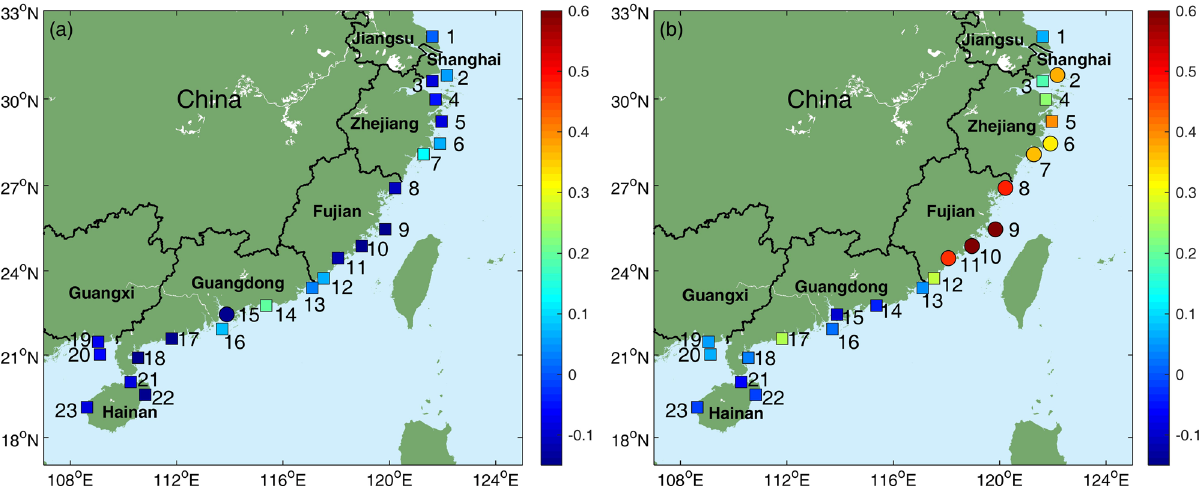
Figure 7. Correlation coefficients between the Niño-3.4 index and annual number of ( a ) Minor-surge events and ( b ) Major-surge events. Figures were plotted using MATLAB R2018b (http:// www. mathw orks.